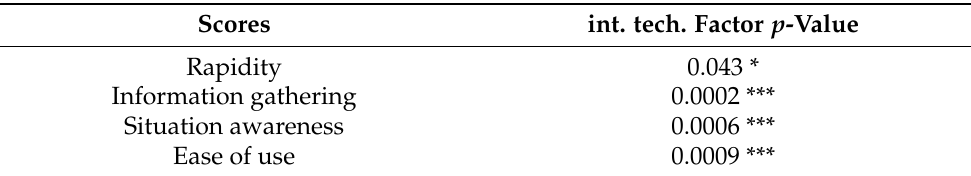
Table 7. HMD application: repeated-measures ANOVA on quality factors scores with interaction technique, scenario, and order factors.